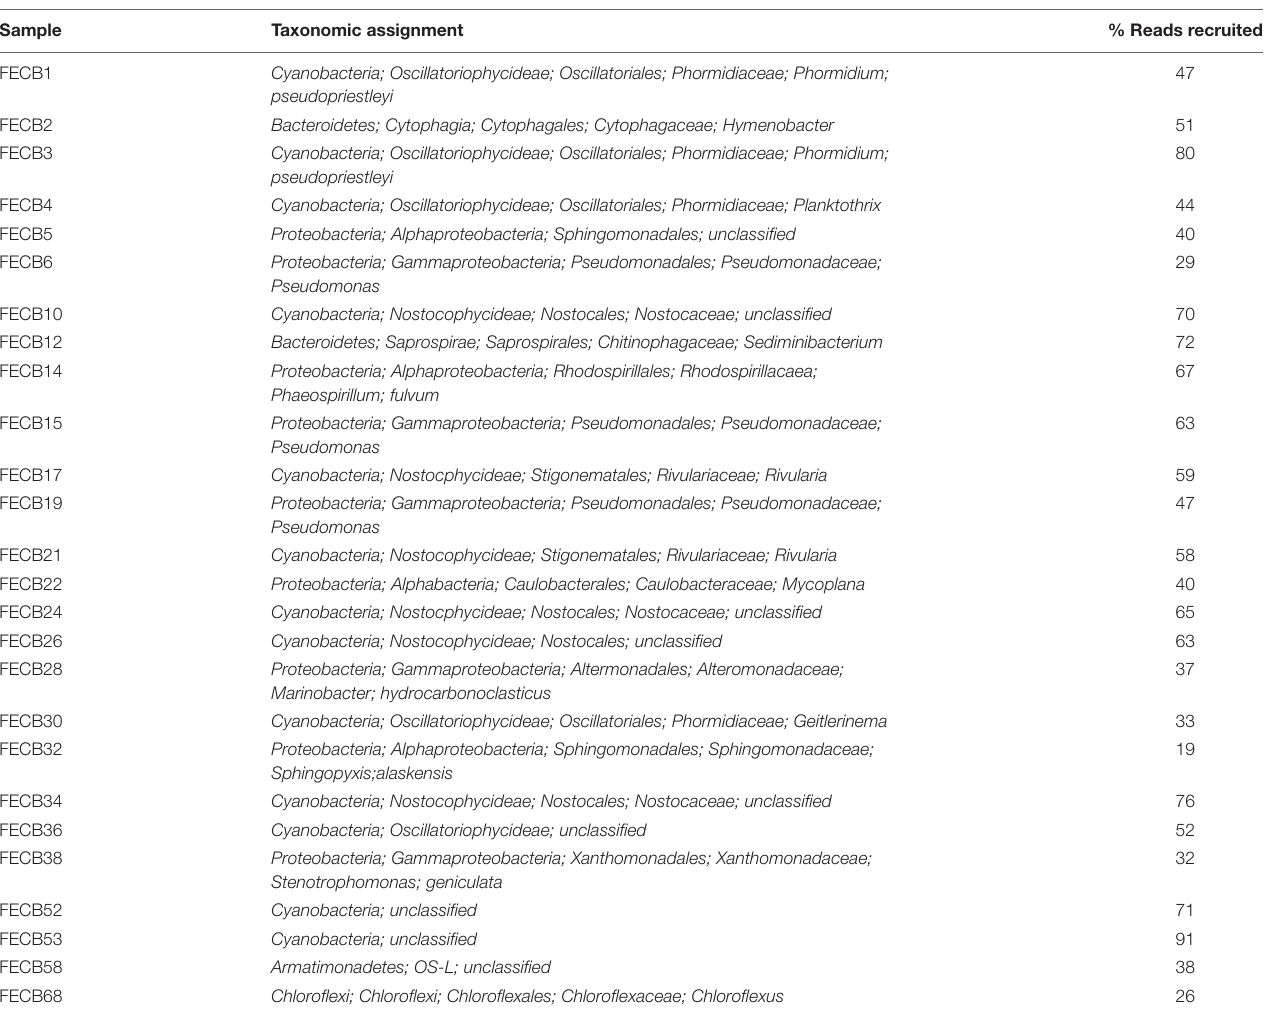
TABLE 4 | Taxonomy relative abundance of dominant OTU identified in each